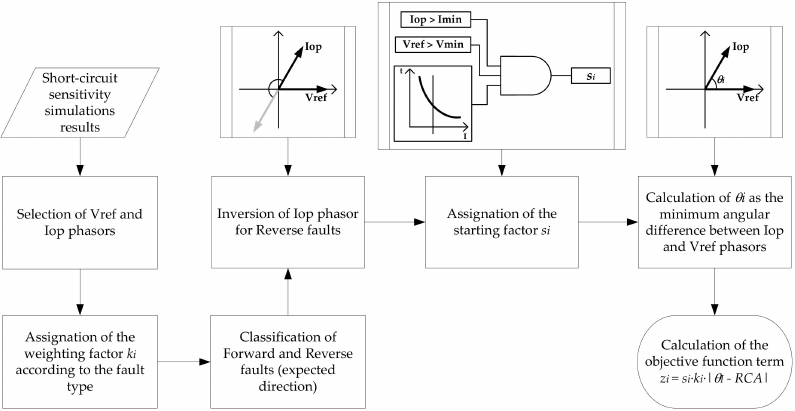
Figure 4. Flowchart for the conditioning of the results prior to the calculation of the Relay Characteristic Angle ( RCA ) through